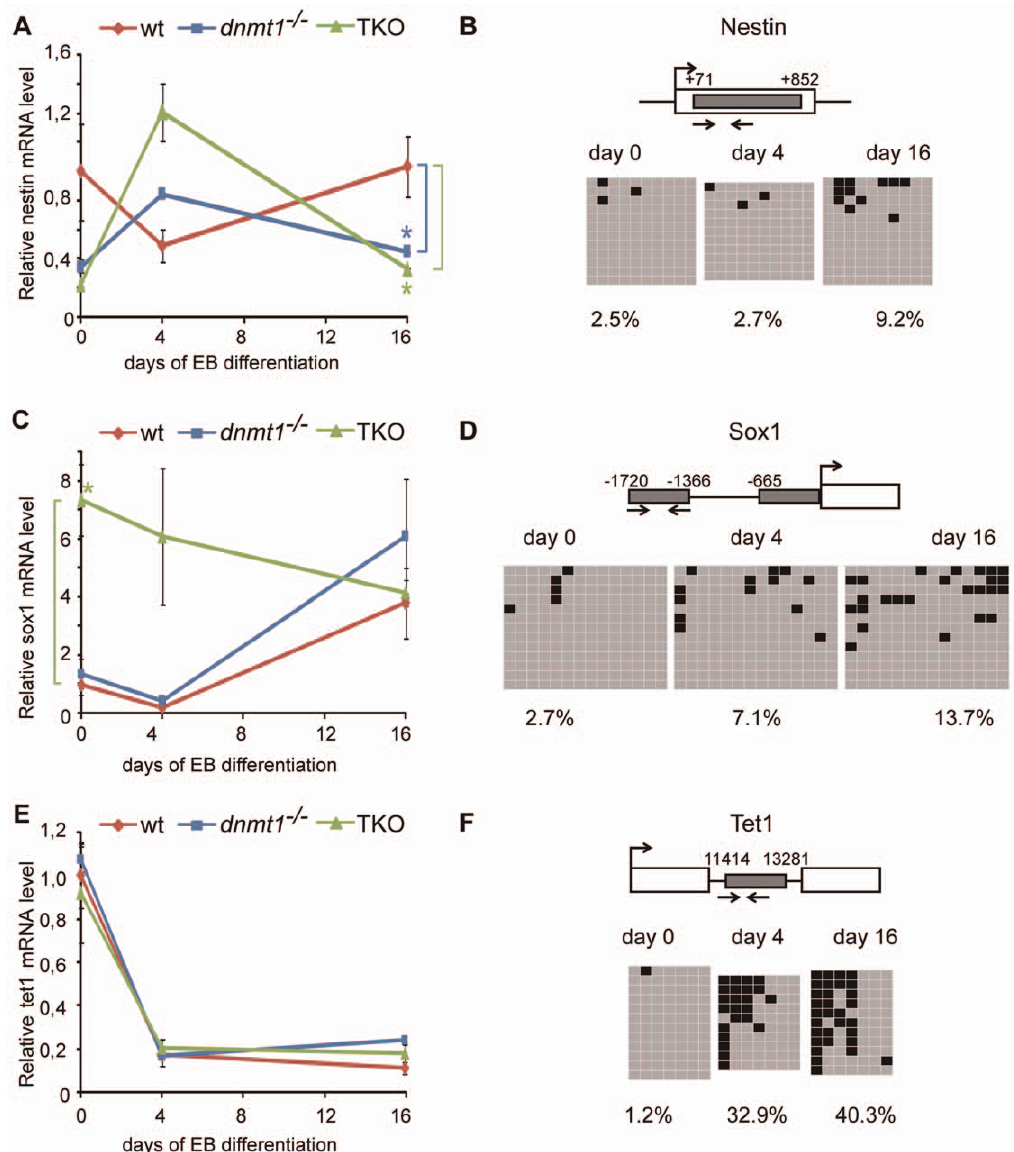
Figure 5. CpG island methylation and disregulated expression of selected bivalent genes in wt and mutant EBs. Transcript levels and CpG island methylation of bivalent genes Nestin (A,B) and Sox1 (C,D) as well as the non-bivalent gene Tet1 (E,F) in undifferentiated ESCs (day 0) and at day 4 and 16 of EB culture. (A,C,E) Transcript levels were measured by RT-qPCR in wt, Dnmt1 2 / 2 and TKO ESCs/EBs as indicated. Mean values and standard errors from three independent biological replicates are shown. All values are normalized to undifferentiated wt ESCs. Asterisks indicates the significance level p , 0.05 (Student t-test). (B,D,F) DNA methylation analysis by bisulfite sequencing in wt ESCs/EBs. In the gene cartoons large arrows indicate transcriptional start sites (TSS), open rectangles represent exons, grey shaded rectangles represent CpG islands and numbers indicate the positions of their borders with respect to the TSS. Small arrows indicate the analyzed regions. In the panels grey and black squares indicate unmethylated and methylated CpG sites, respectively. Percentages of total CpG methylation within the analyzed regions/clones are reported at the bottom of each panel.